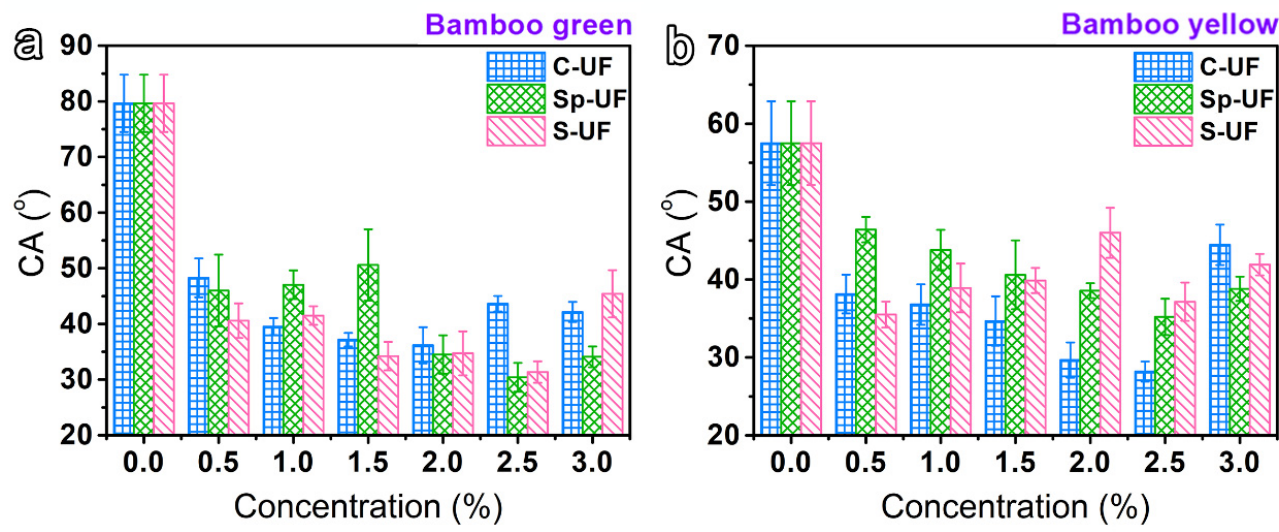
Figure 3. The CA curves of the UF and reconfigured UF resins on the surface of ( a ) bamboo green and ( b ) bamboo yellow.